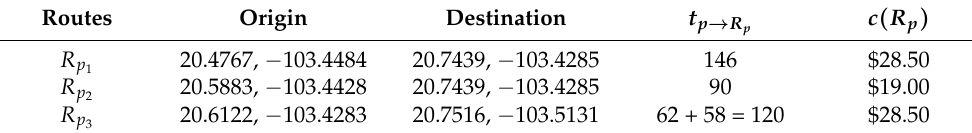
Table 1. Commuting data for the passenger p ∈ { p 1 , p 2 , p 3 } traveling via public transportation.